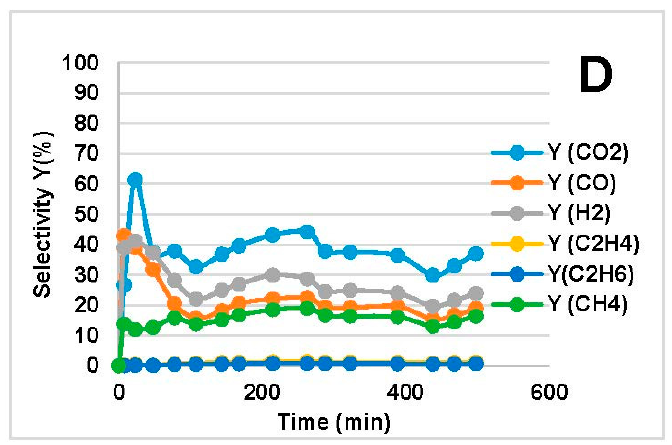
Figure 3. Concentration and selectivity profiles of bio-oil WU SR at 800 °C: ( A , B ) WHSV = 1.8 g/g cat /h; and ( C , D ) WHSV = 7.1 g/g cat /h.